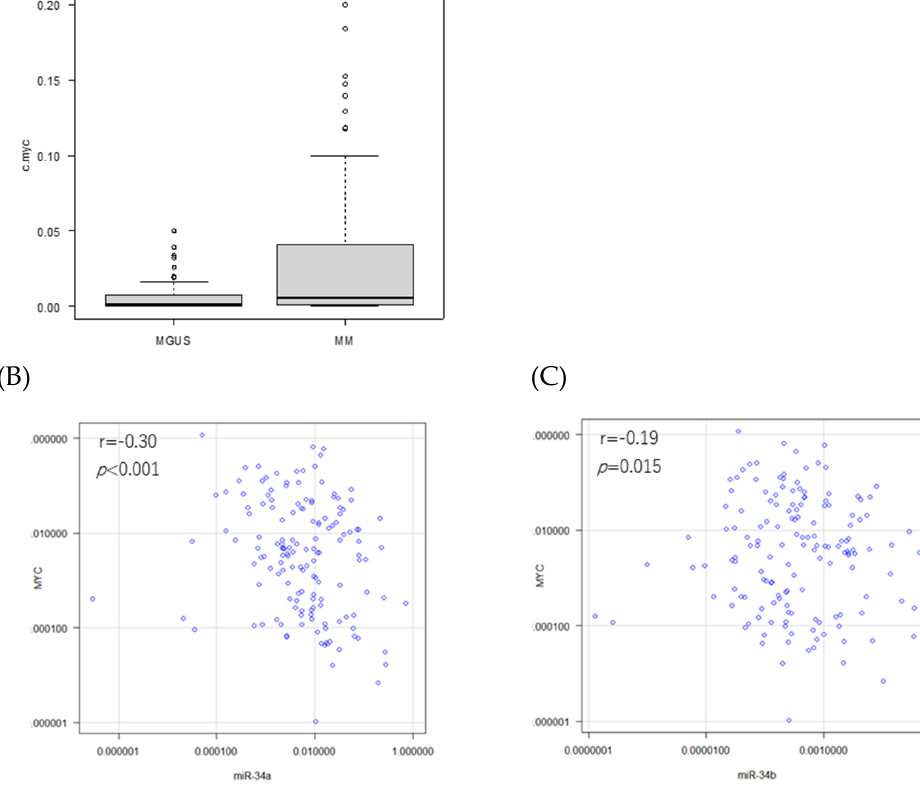
Figure 4. MYC and miR-34 expressions in the plasma cells obtained from the patients. ( A ) MYC expressions in MGUS and MM. Correlations between MYC mRNA and the miR-34 family for all patients. ( B ) MYC and mature miR-34a, ( C ) MYC and mature miR-34b. Each dot represents an individual patient.